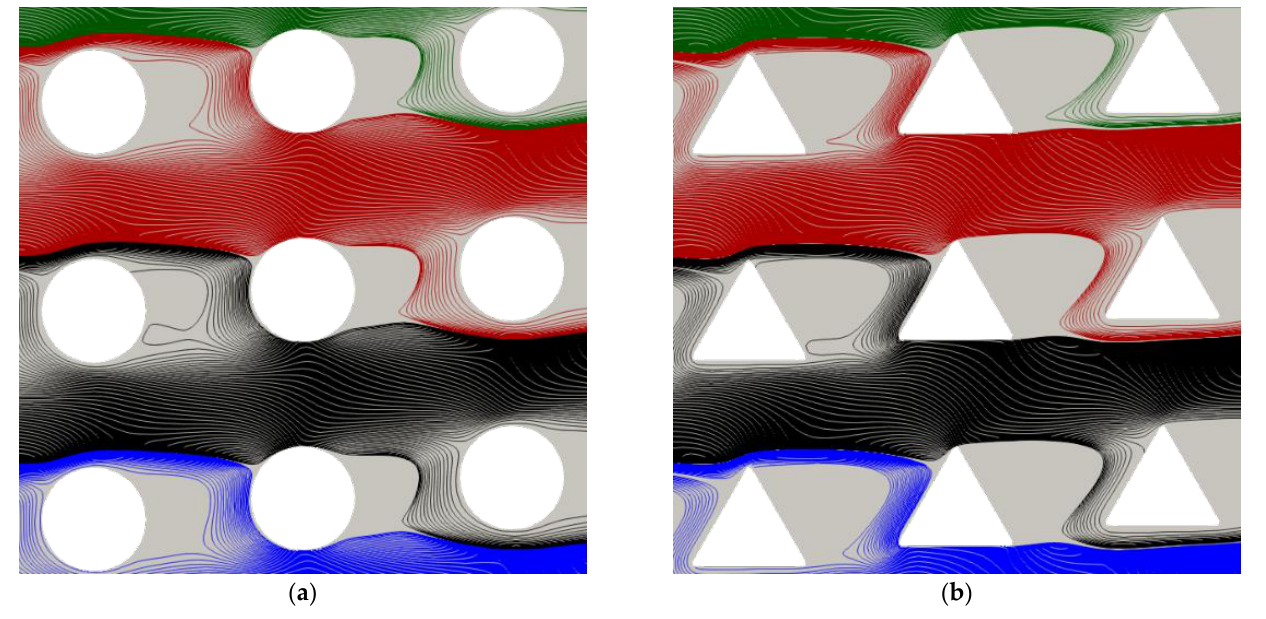
Figure 9. Here, bundles of streamlines color-code the first flow lanes that cause particle separation by passing below the following posts ( Re = 50, H / G = 1). The static vortices in the flow wake cause deflection and compression of the flow lane, especially for triangular posts. ( a ) Cylindrical posts, ( b ) triangular posts.